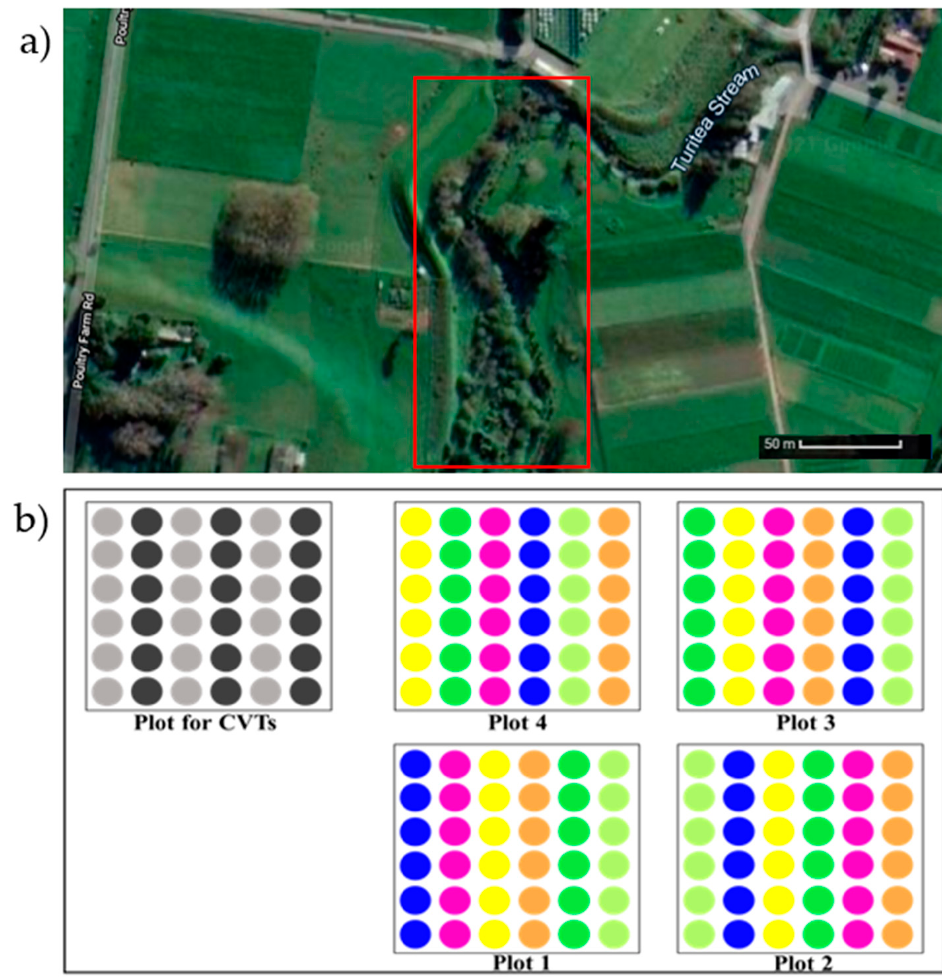
Figure 1. ( a ) Google earth image indicating study area inside the red square. ( b ) Layout of m¯anuka plants in the area, with colours indicating different genotypes. CVT2 and CVT4 were in a separate plot within the study area. Plants were spaced 1.5 m within plots, and five samples per genotype were collected using non-adjacent plants at the edge of each plot for convenience when placing equipment and to avoid damaging nearby plants.